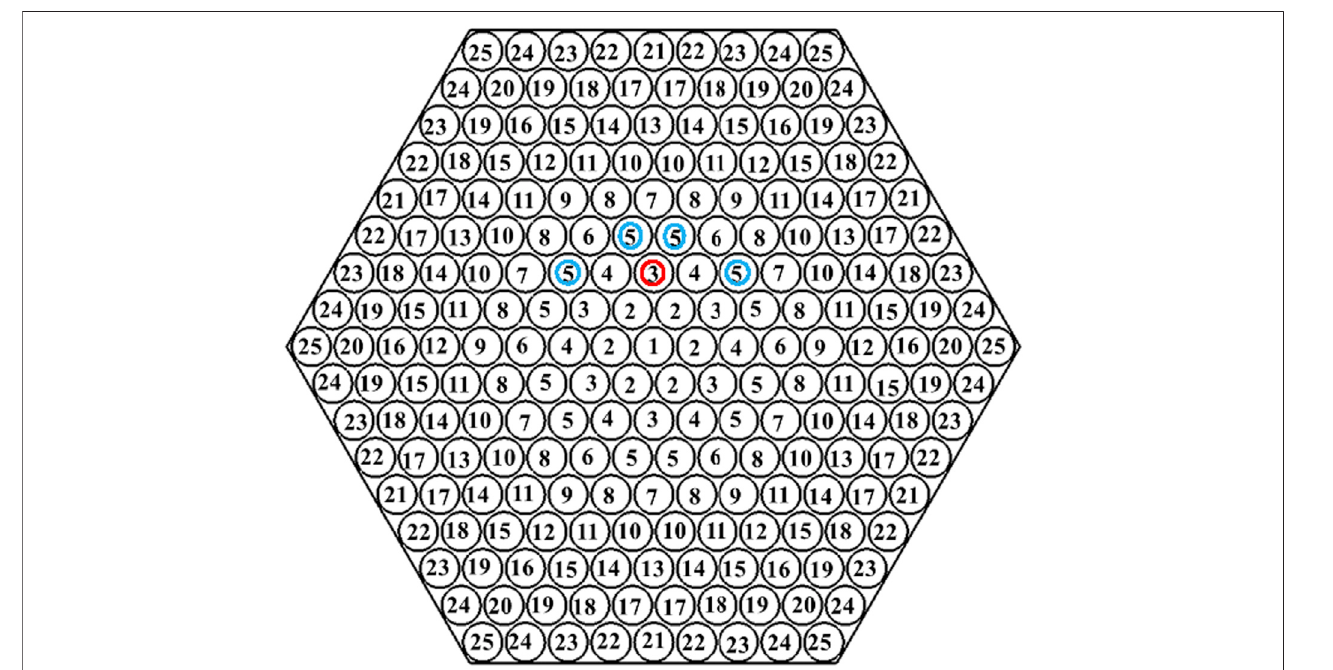
FIGURE 5 | Cross-section of an enclosed hexagonal array and rod